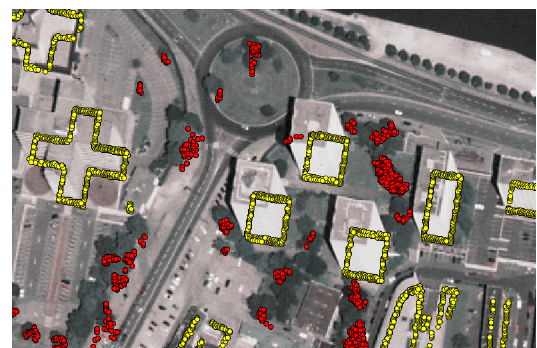
Figure 2: First echoes extracted from waveforms labelled as ” building edge “ in Section 3.2. Yellow (resp. red) points are located on building (resp. vegetation) areas, with respect to the ground